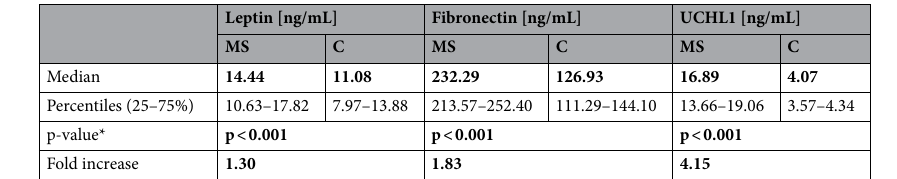
Table 2. Plasma leptin, fibronectin, and UCHL1 concentrations in MS patients as compared to the control group (C). Significant values are in bold. MS multiple sclerosis. *A p-value < 0.05 is considered to show a significant difference between groups (according to the Mann–Whitney U test).